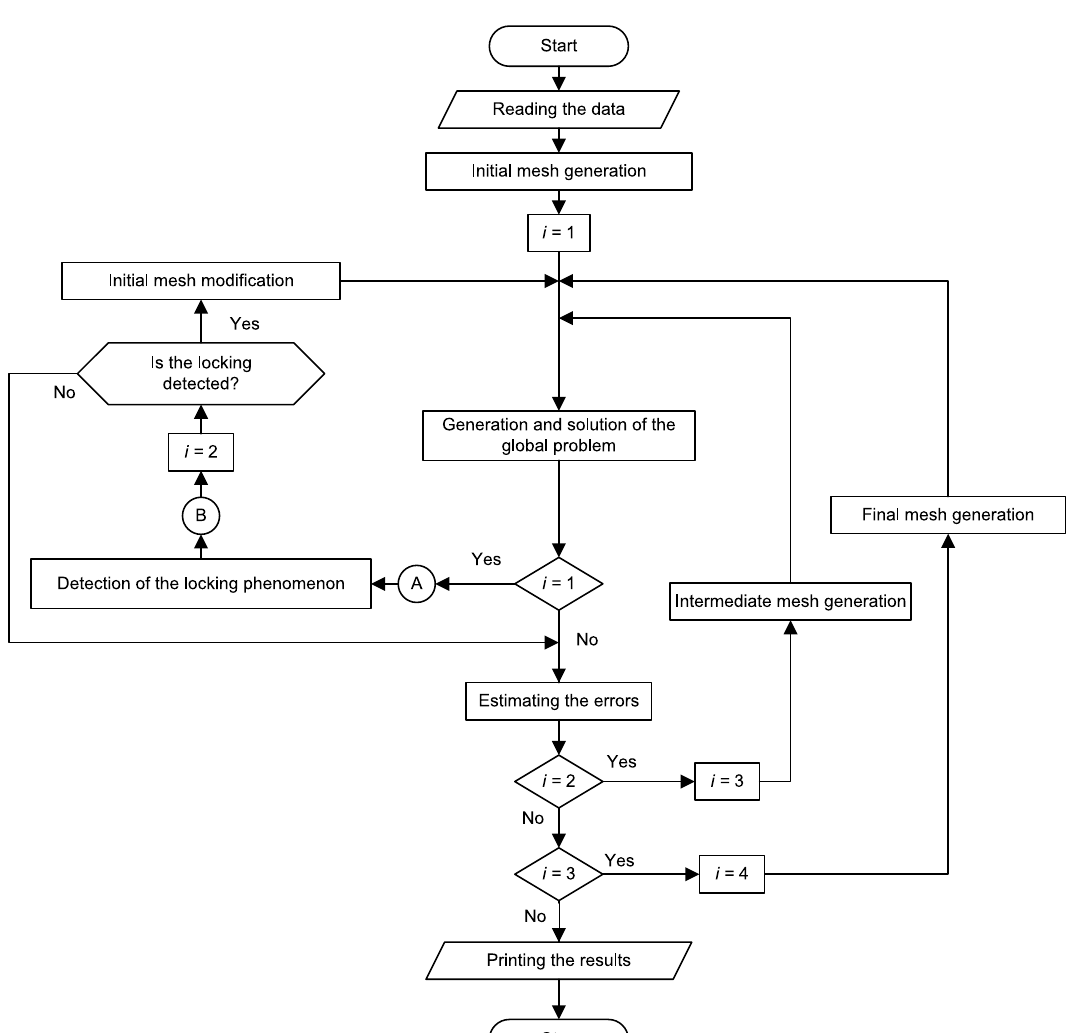
Figure 1. Three-step adaptive procedure extended with the fourth modification